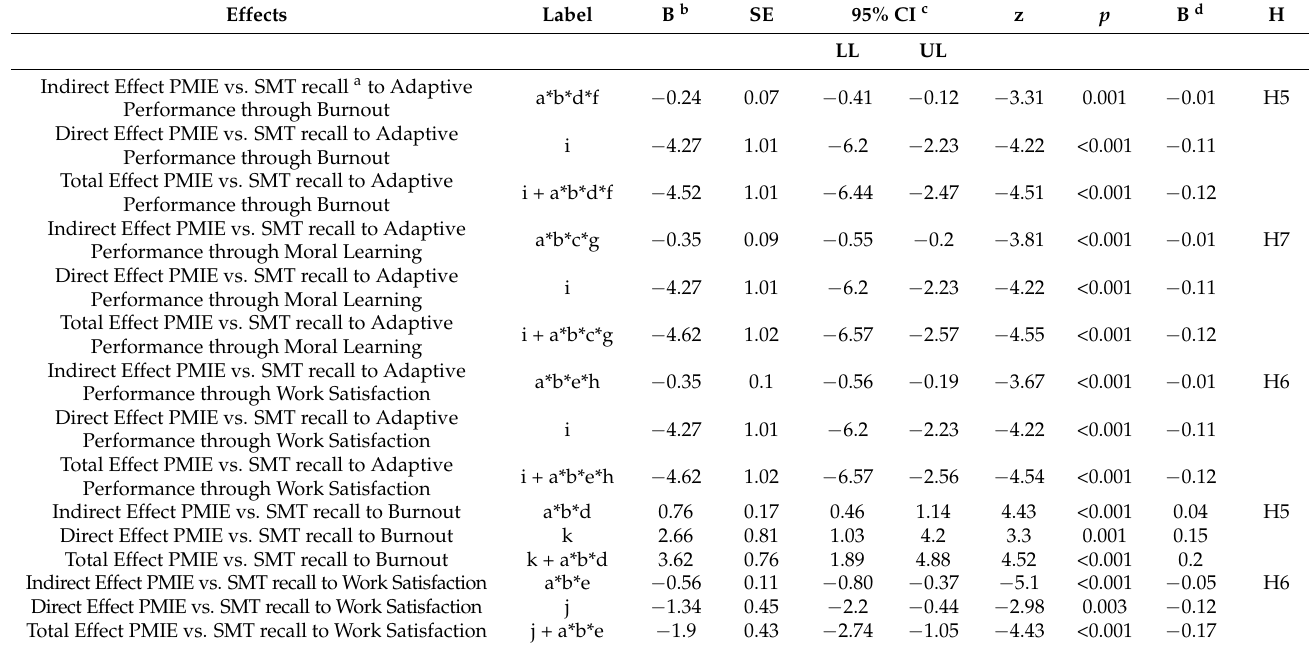
Table A3. Path Analysis Indirect Effects after outlier